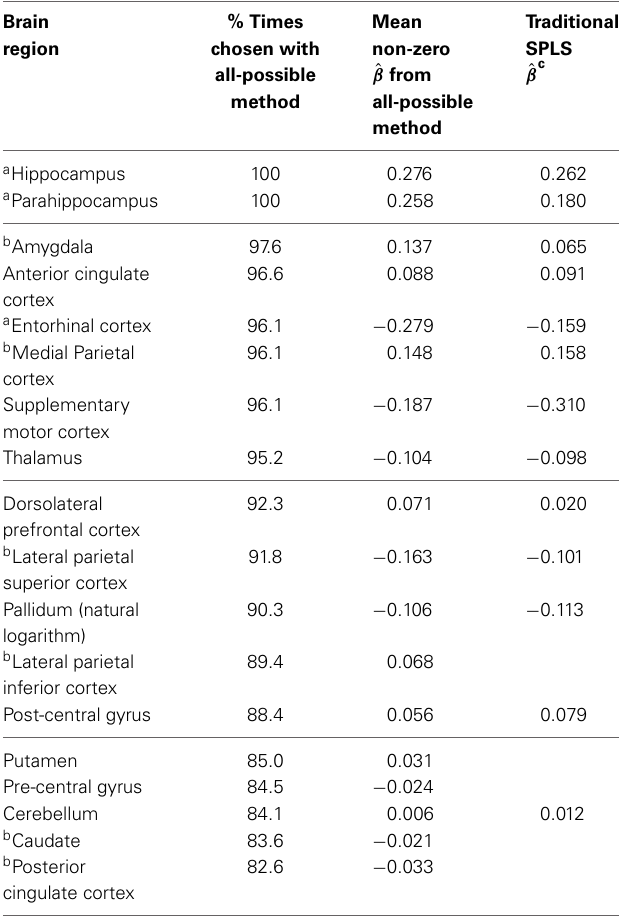
Table 3 | Results from all-possible (first two columns) and traditional (last column) SPLS for the Healthy Brain